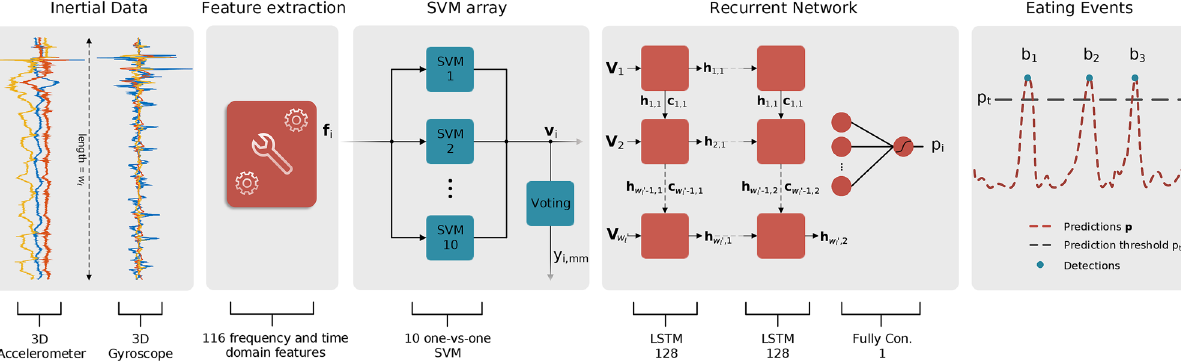
Figure 1. Figure depicting the overall pipeline of the micromovement recognition/bite detection part of the algorithm. From left to right, the windowed 3D accelerometer and gyroscope streams of length w l are transformed into the 116-dimensional feature vector f i . Next, using an array of ten one-versus-one SVM the feature vector f i is transformed into the 10-dimensional SVM prediction score vector v i . By applying a voting scheme to the one-vs-one scores of the ten SVM (i.e., to the v i vector) we obtain y i , mm which indicates the micromovement label that corresponds to the i th window. Processing of additional sensor windows leads to the creation of the meal’s SVM score matrix V and label vector y mm . Furthermore, by processing windows of V with length w ′ l , the RNN outputs the probability p i that the given window sequence is a food intake cycle. Variables h i , j and c i , j are used to represent the i th hidden output and cell state of the j th LSTM layer, respectively. The rightmost part of the figure illustrates the local maxima search in the meal’s prediction vector p . Variables b 1 , b 2 and b 3 represent three detected bites, while p t represents the prediction